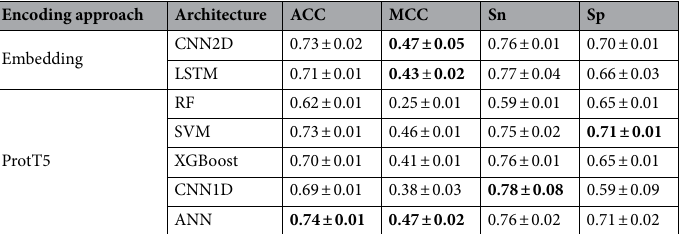
Table 2. 10-Fold cross-validation results on the training set of Embedding module, ProtT5 module with different ML and DL models. The highest values in each category are